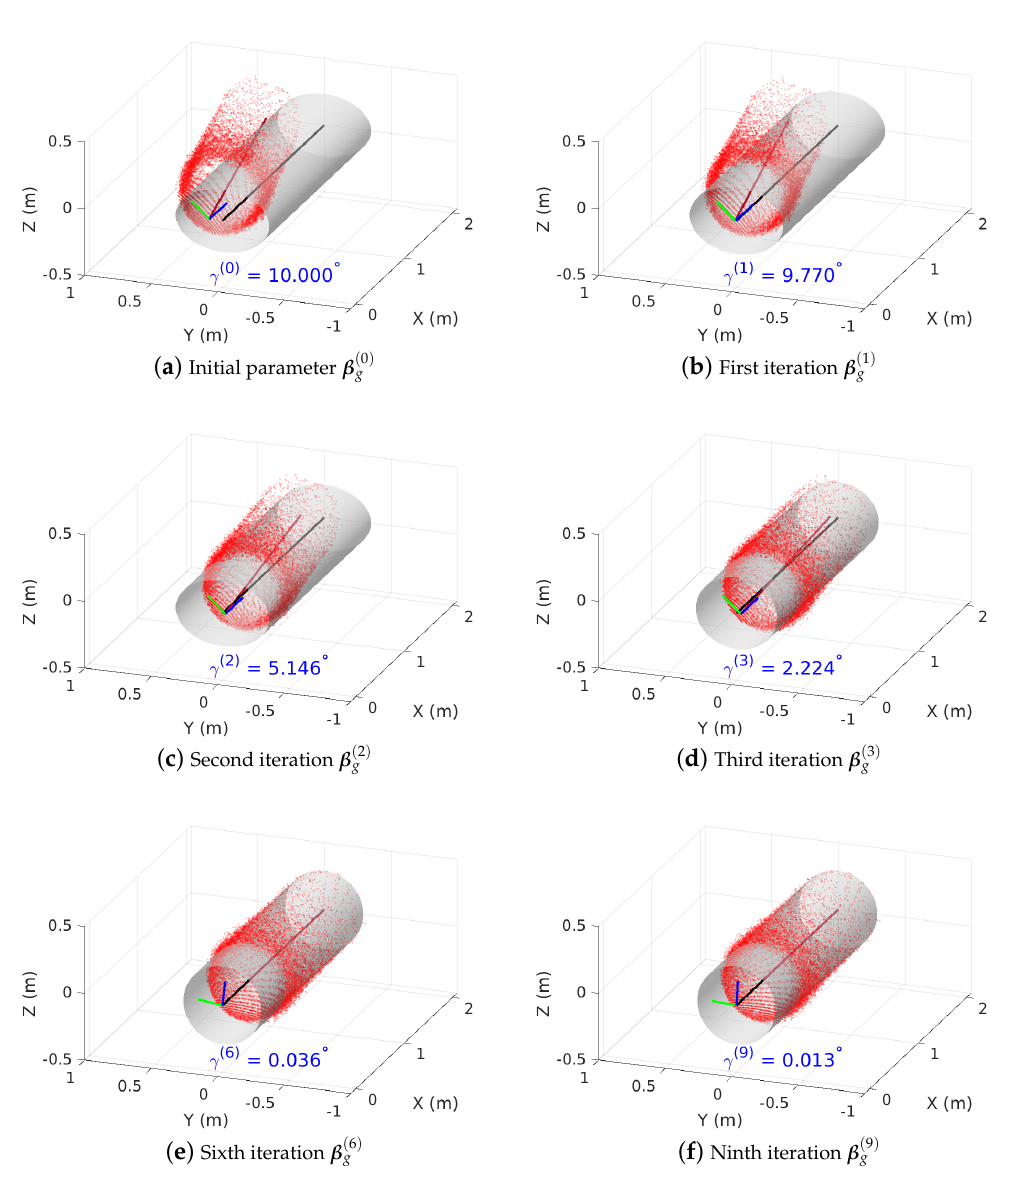
Figure 10. Accuracy of iterative LMA, where the pipe and point cloud are represented by a gray cylinder and m red points,